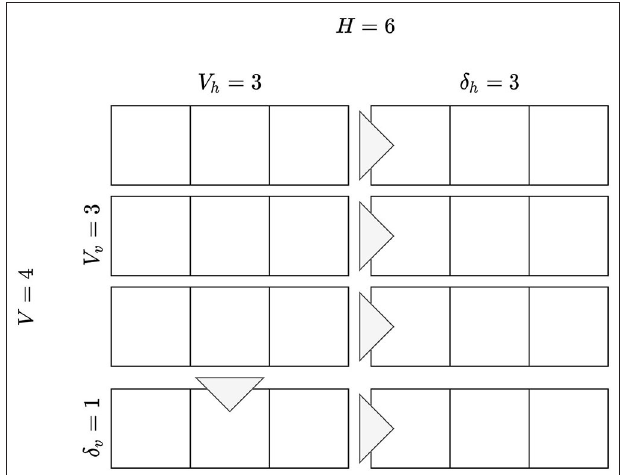
FIGURE 5 | An example interface with 4 carousels of 6 elements each, where 3 carousels, with 3 items each, are visible. A horizontal swipe reveals 3 items, while a vertical swipe reveals one additional